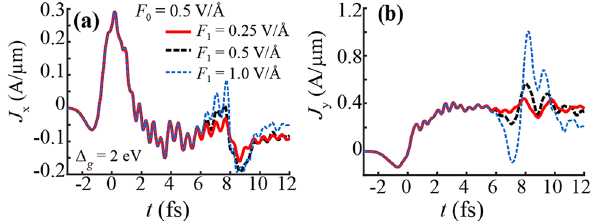
Figure 5: Electric currents J x [panel (a)] and J y [panel (b)] generated by a left-hand circularly polarized pulse (2 fs ≥ t ≥ − 2 fs) followed by a linearly polarized pulse (10 fs ≥ t ≥ 6 fs). The amplitude of the = 0 . 5 V ̊ A − 1 , while the corresponding circularly polarized pulse is F 0 amplitudes of the linearly polarized pulse are marked in panel (a). The band gap is 2